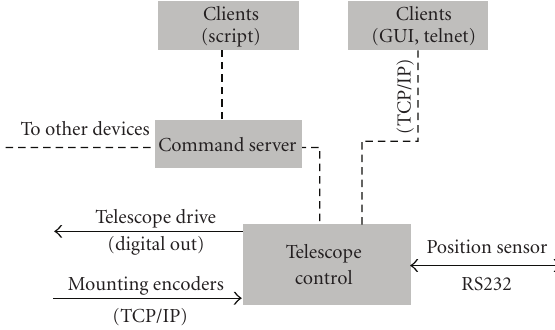
Figure 2: Integration of the telescope control system into the observatory